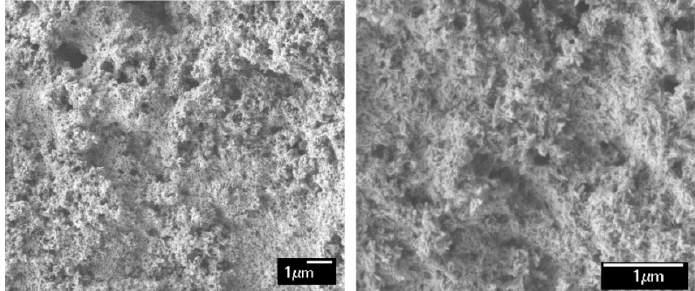
Figure 8. SEM of sol–gel-deposited CaP microstructure in different magnifications of the same area [78].